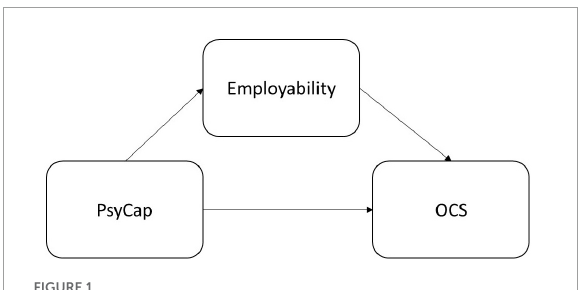
FIGURE1 The hypothesised (partial) mediation model of objective career success